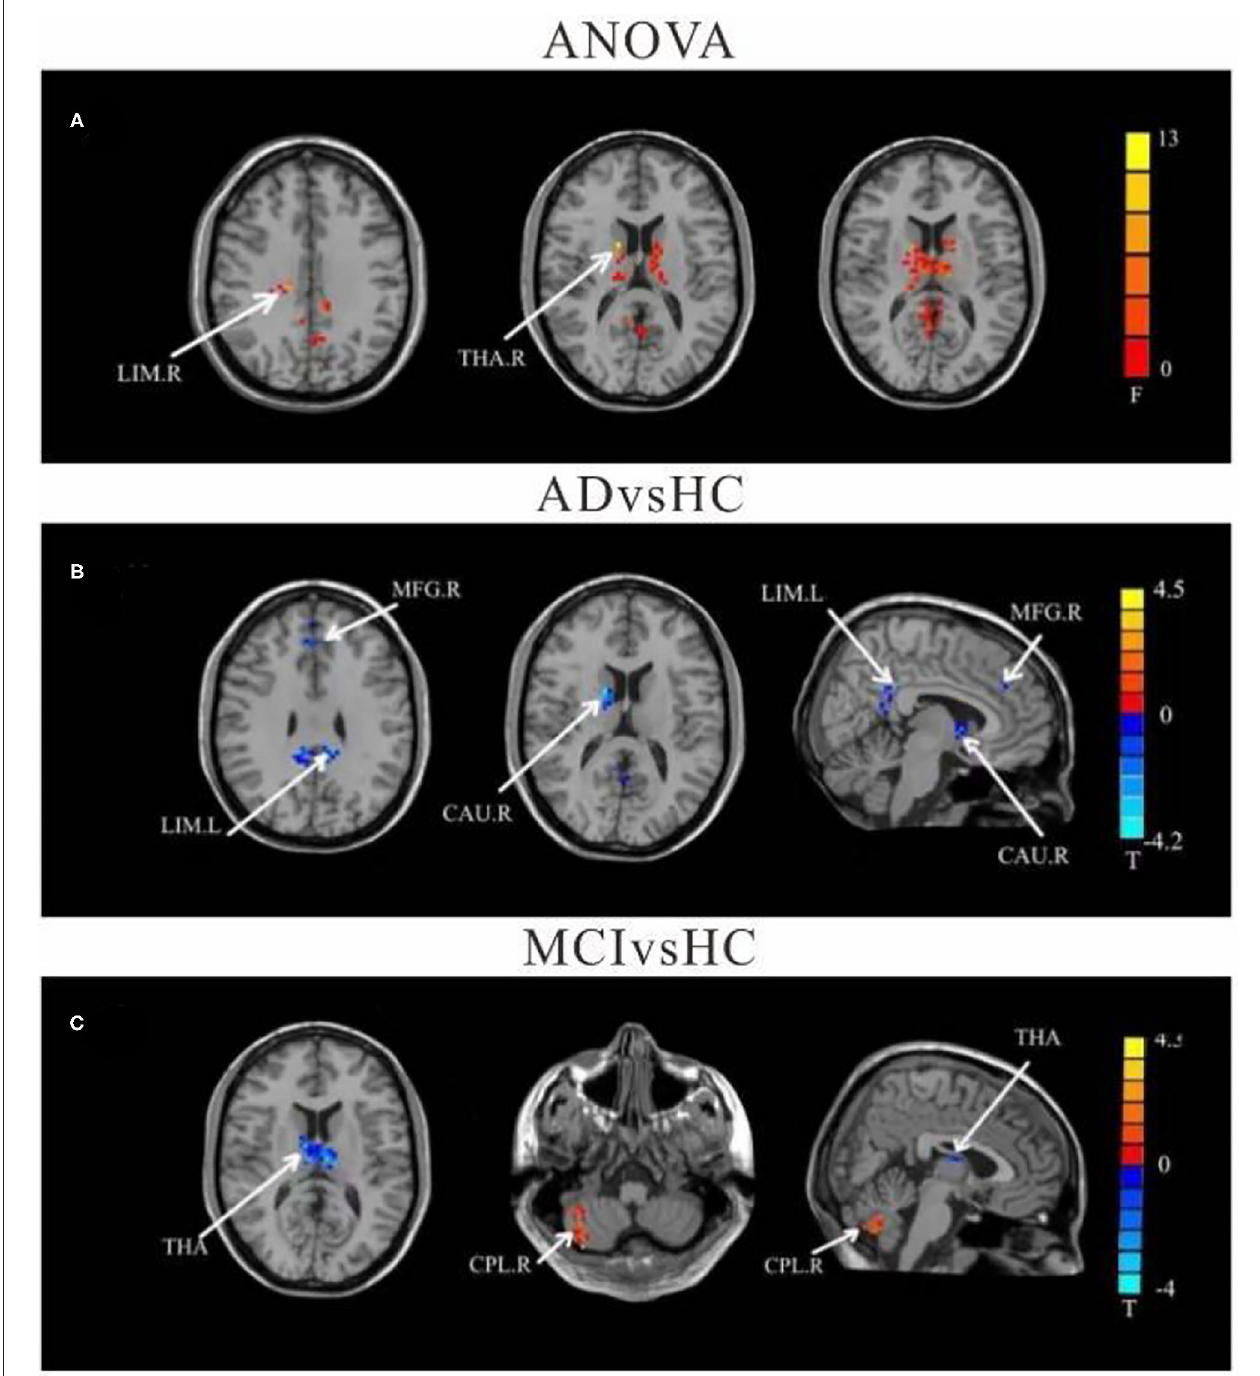
FIGURE 2 | Differences of FC values in the cerebellum left crus II. (A) Brain regions showing significant differences in FC of the left cerebellum crus II based on analysis of variance (ANOVA) analysis between HC, AD, and aMCI, p < 0.05, the cluster size > 100 voxels). (B,C) Results of post-hoc two-sample T -tests in voxel-wise analysis (Bonferroni corrected, cluster size ≥ 30 voxels, p < 0.05). AD, Alzheimer’s disease; aMCI, amnestic mild cognitive impairment; HC, healthy controls; LIM, limbic lobe; THA, Thalamus; MFG, Middle Frontal Gyrus; CAU, Caudate; CPL, cerebellum posterior lobe; L, left; R, right.